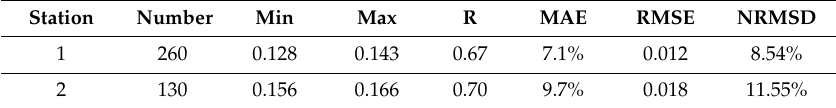
Figure 5. Comparison of airborne LiDAR-derived results with traditional measurements. ( a , c ) are the comparison results for S1; ( b , d ) are the comparison results for S2. Table 1. The curve-fitting statistics between LiDAR inversion and in-situ